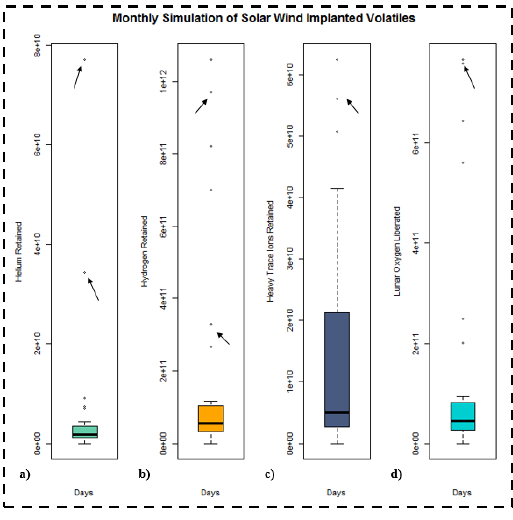
Figure 2. Simulated retention of Solar wind volatiles a) 3 He, b) H, c) Trace heavy ions and d) Lunar oxygen Figure 1. Simulated surface temperature (in K) for an equatorial patch of the lunar regolith.